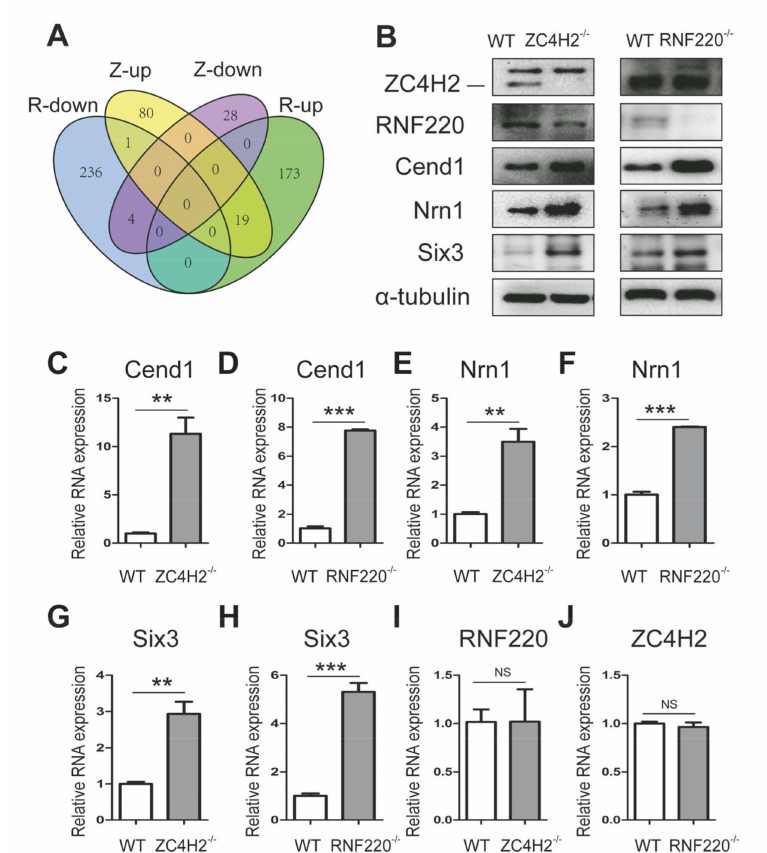
Figure 5. Validation of the shared DEGs generated from RNA-Seq between the ZC4H2 − / − and RNF220 − / − NSCs. ( A ) Venn diagrams of shared DEGs between the ZC4H2 − / − and RNF220 − / − NSCs. In total, 24 DEGs were shared between the two groups. Z-up / down and R-up / down represent ZC4H2-Seq upregulated / downregulated DEGs and RNF220-Seq upregulated / downregulated DEGs, respectively. ( B ) Western blot analysis for ZC4H2, RNF220, Cend1, Nrn1, and Six3 protein expression level in WT, ZC4H2 − / − , and RNF220 − / − NSCs. ( C – J ) qRT-PCR analysis showing the relative mRNA levels of Cend1, Nrn1, Six3, RNF220, and ZC4H2 in WT, ZC4H2 − / − , and RNF220 − / − NSCs. β -actin was used as an internal control. NS represents no significant di ff erence ( p > 0.05). ** p < 0.01, *** p < 0.001, two-tailed Student’s t -test. Data represent mean ± SD from three independent biological